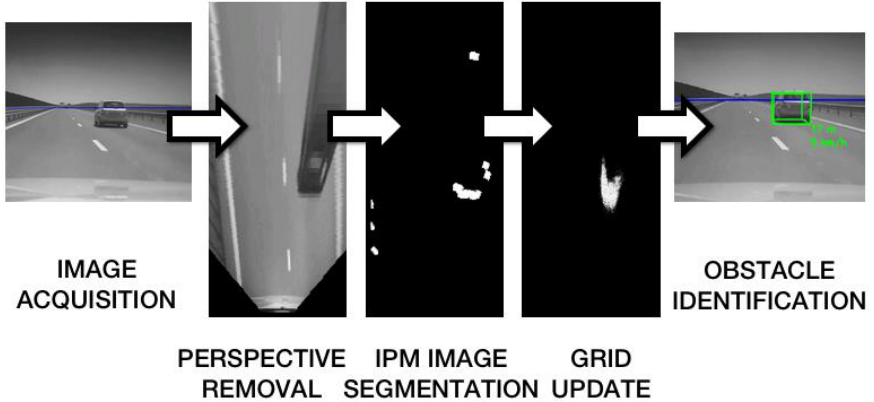
Figure 1. Overview of the obstacle detection process.